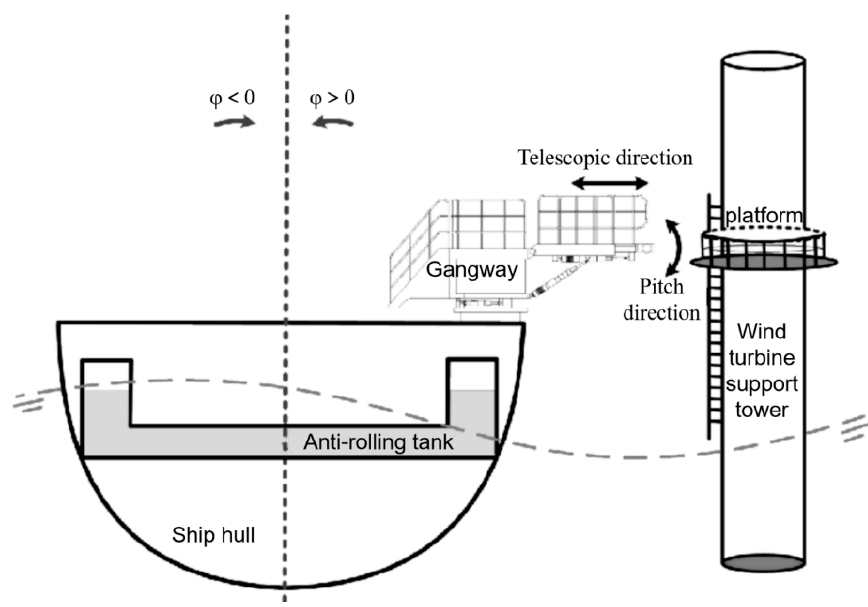
Figure 1. Schematic diagram of the ship-tank-gangway system.